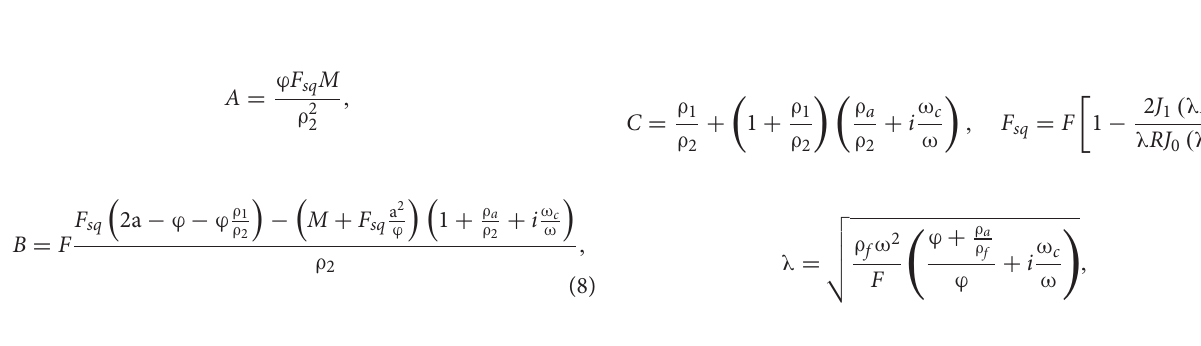
FIGURE 6 | (A) P-wave velocity Vp dispersion and (B) attenuation factor 1/Qp for various viscosity coefficients of the fluid